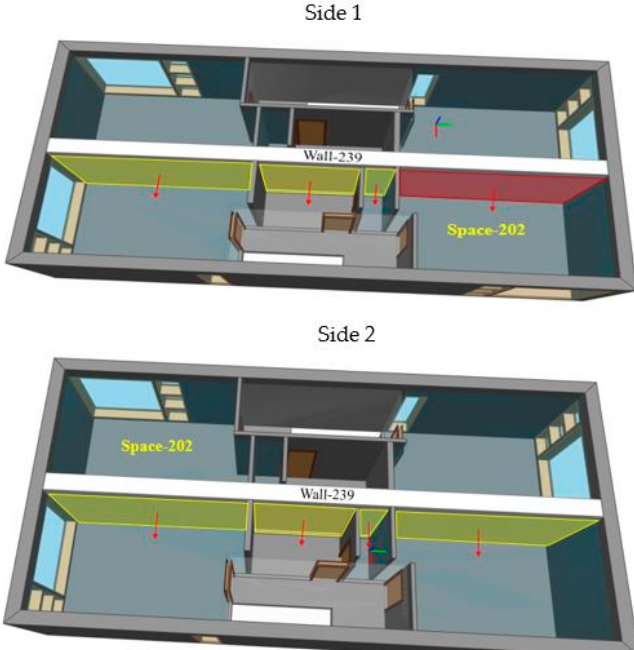
Figure 10. Find the adjacent spaces for space-202.